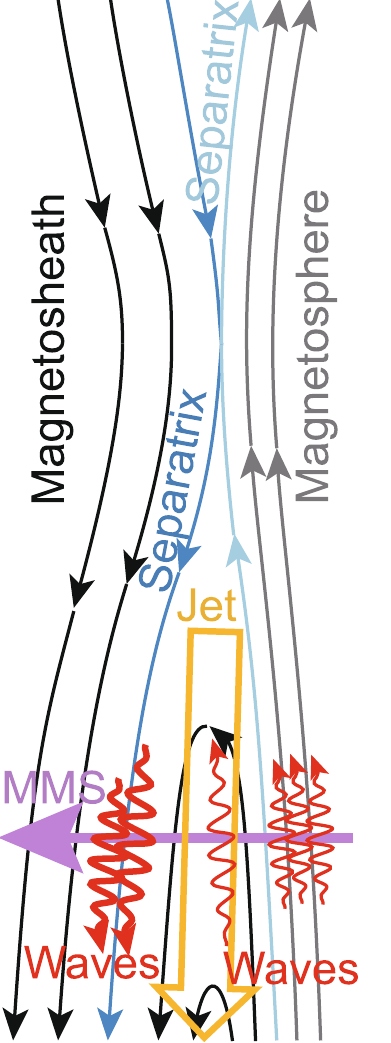
Fig. 2 | Schematic of the magnetopause crossing and whistler-mode waves (Event 1). MMS crossed the magnetopause southward of the reconnection site from the terrestrial magnetosphere to the magnetosheath. The interval with whistlermodewavesfocusedasEvent1(around15:59:19UTon25December2016) was close to the magnetosheath-side separatrix (blue curve) of the magnetopause reconnection that occurred northward of